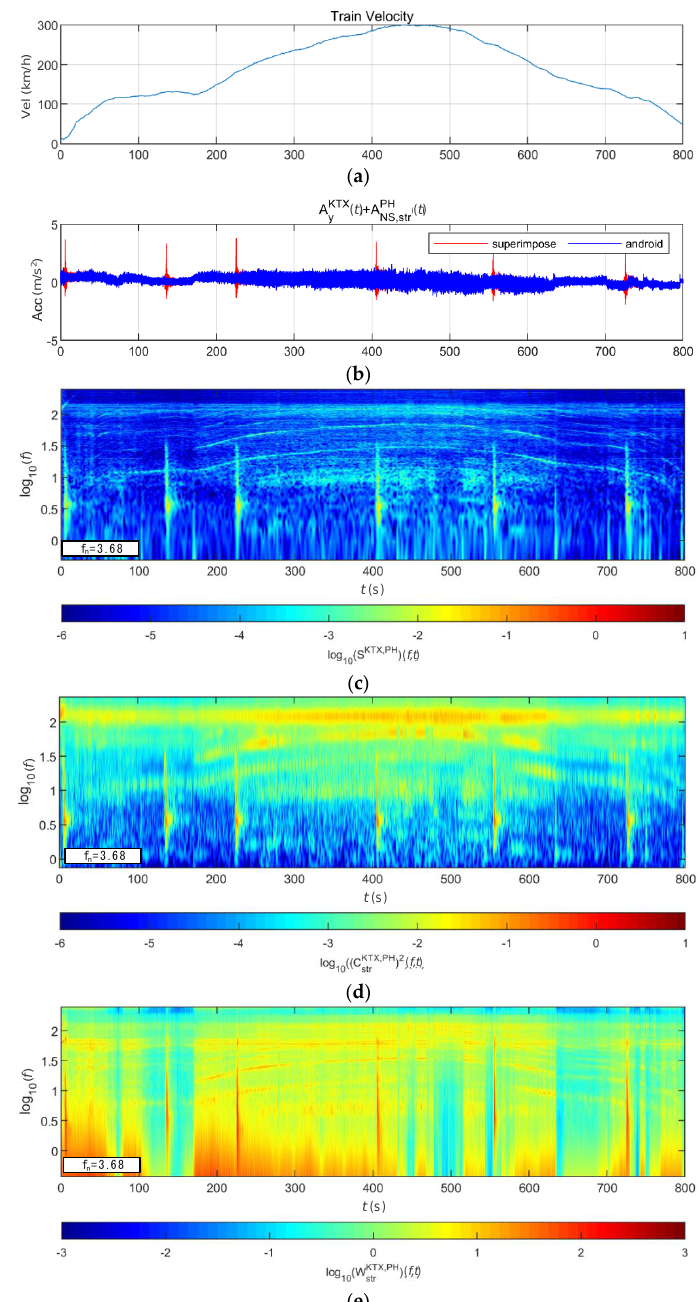
Figure 36. Combination of train data with BR3 bridge-response data from the Pohang earthquake (scaled to 1000-year return period): ( a ) velocity; ( b ) lateral acceleration time series; ( c ) STFT; ( d ) WT; ( e ) WVD.